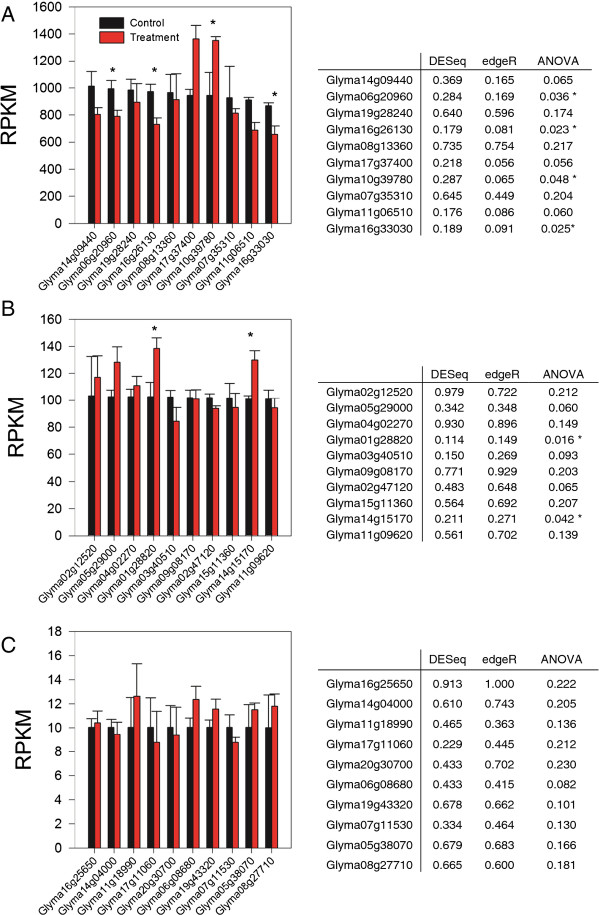
Identification of type II error across a range of transcript abundance levels. RPKM values were compared between control and treatment for 10 randomly selected genes, ranging from high (A), moderate (B) and low (C) abundance transcripts. Also included are the p-values from DESeq, edgeR and an ANOVA performed using RPKM data. Asterisks signify p-value below p = 0.05.